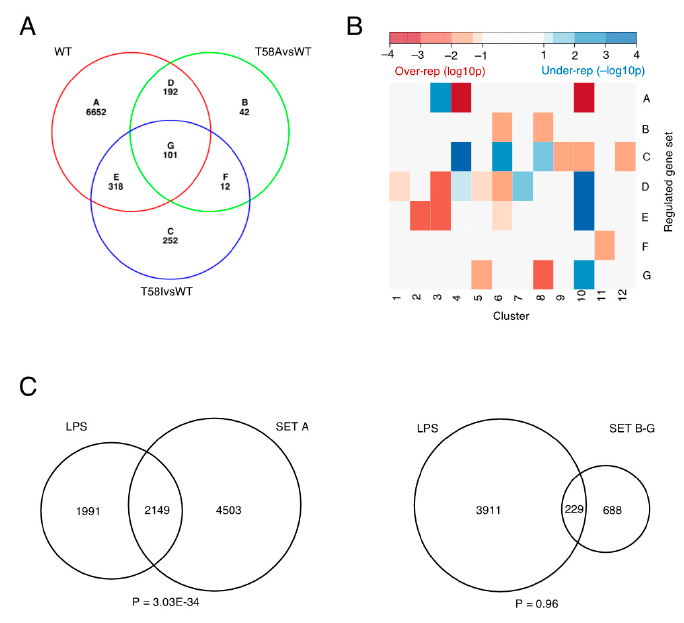
Figure 6. Differences in differentially regulated genes between MYC WT, MYC T58A and MYC T58I. ( A ) Venn diagram representation of genes with significant transcript level changes (FDR q-value ≤ 0.01 and max fold change ≥ 2). The diagram shows the set of genes with significant regulation in MYC WT (WT) and its overlap with the sets of genes that are regulated significantly differently from WT MYC in MYC T58A (T58A vs. WT) and/or MYC T58I (T58I vs. WT). ( B ) Heatmap representation of Fisher’s exact test significance levels for intersects between the Venn diagram subsets in panel A (A–G) and genes in clusters 1–12. Intersects with a significantly larger overlap than expected are represented in red (over-rep) and intersects with an overlap significantly smaller than expected are represented in blue (under-rep). ( C ) Comparison differentially regulated gene sets (A and B–G) with lipopolysaccharide (LPS) regulated genes, representing normal MYC target genes. The names of LPS-regulated genes were obtained from previously published work [17]; supplementary data file “embr201947987-sup-0004-datasetev2.xlsx”, all groups. Venn diagrams show a significant overlap between Set A genes and LPS-regulated genes and a smaller overlap for Set B–G genes (all sets except for Set A) that is not statistically significant. p -values to test over-representation of genes in the overlaps are shown (Fisher’s exact test,